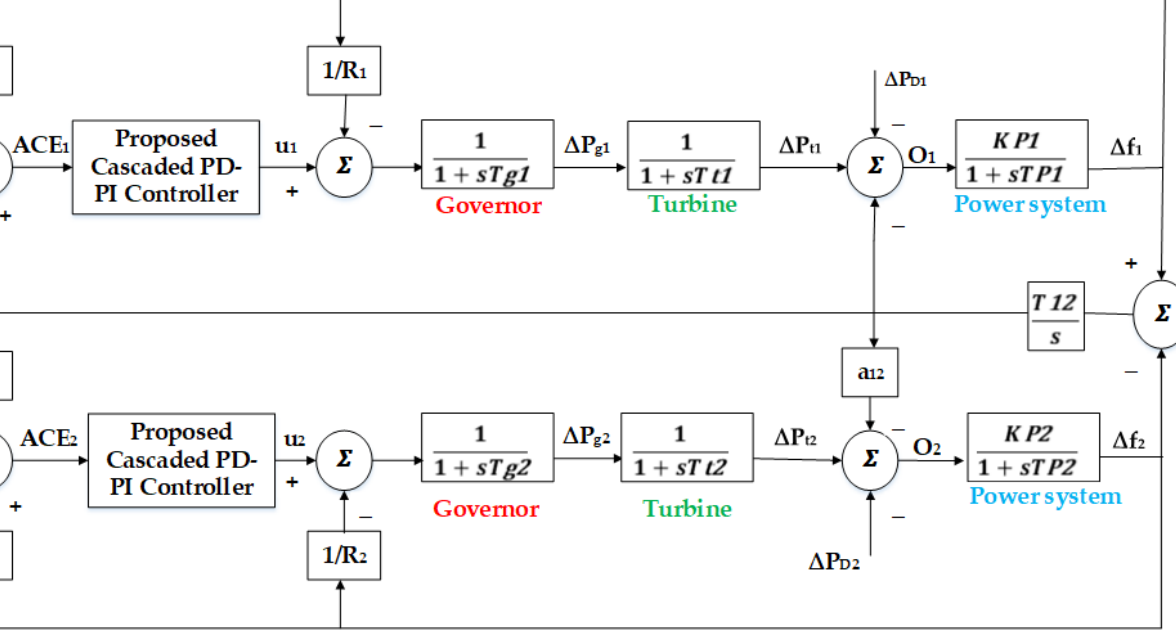
Figure 1. Block diagram for a two-area power system model [25,42].